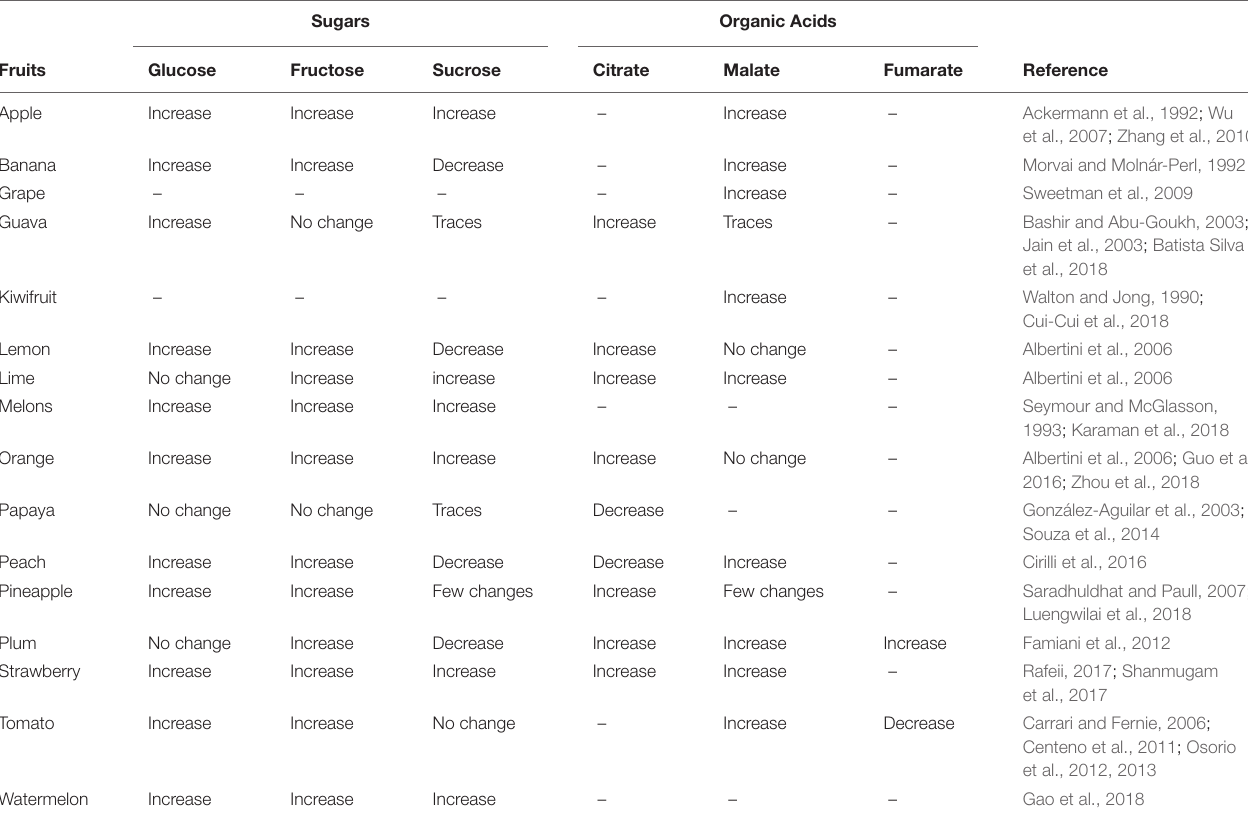
TABLE 2 | Metabolic behavior of different sugars and organic acids present in the mesocarp of different fruit during growth and ripening under optimal growth